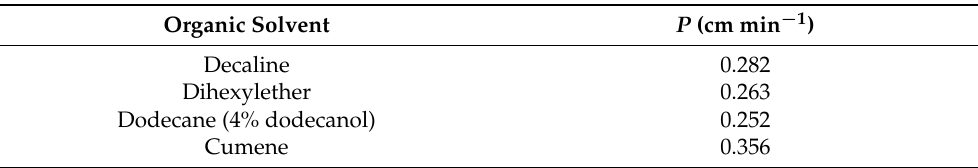
Table 1. Effect of the organic diluent on Cd permeability. Feed phase: 10 mg L − 1 Cd in 2 M NaCl; Aliquat 336 concentration: 0.5 M.